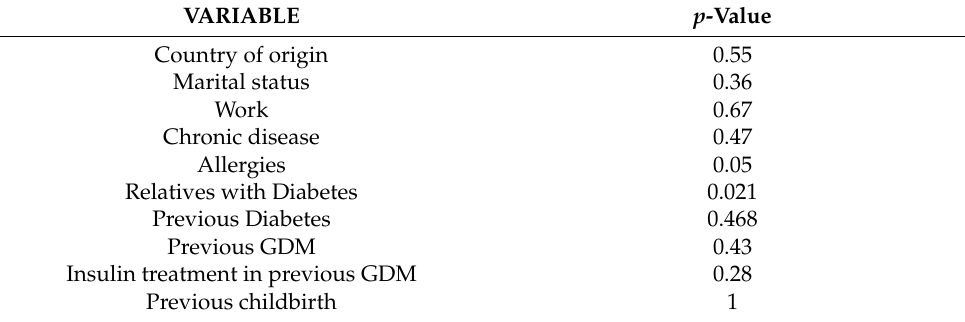
Table A3. Significant differences between women with GDM and normoglycemic women, in the presence of relatives with diabetes, medical history, demographic data.